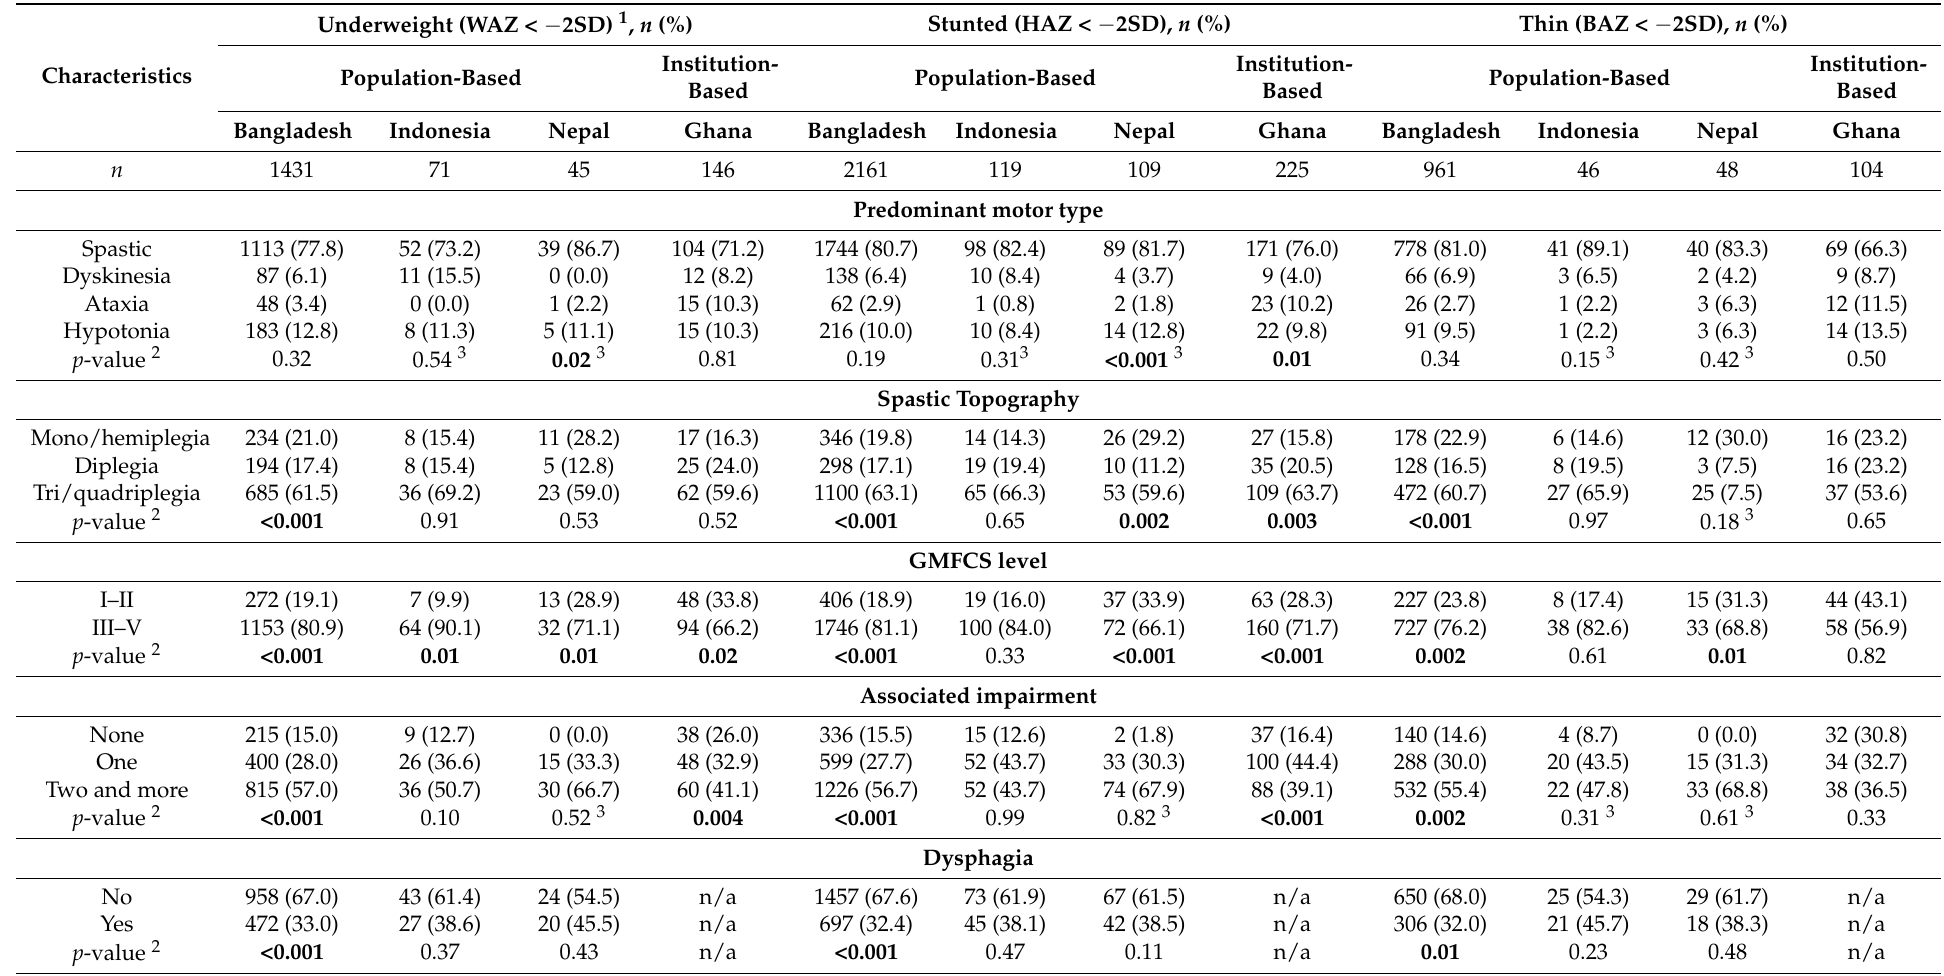
Table 3. Nutritional status of the participating children according to their clinical